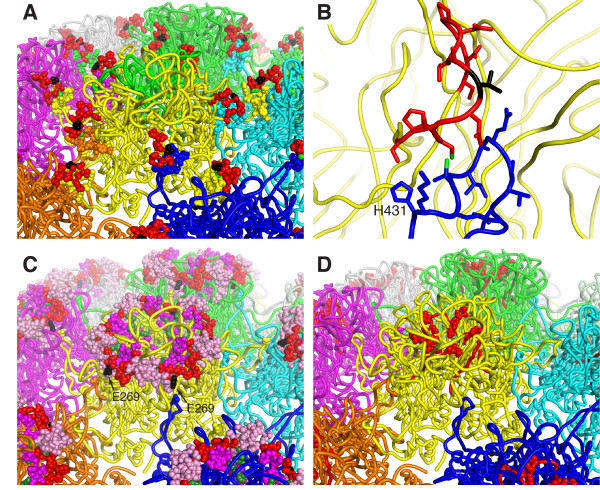
Fine mapping of antibody epitopes on the HPV16 capsid. (A) Same view as in Figure 7B, with the H16.H5 epitope (residues 173-185) shown in red. Side chains in the C-terminal arms of neighboring capsomeres that partially occluding the H16.H5 epitope are shown as colored spheres (not red). The conserved disulfide bond between Cys175 and Cys428 is highlighted with green spheres. The HPV16-specific Val178 is shown in black. (B) Close-up of the H16.H5 epitope from the subunit in the foreground of (A) with the same coloring scheme as in (A). (C) Same view as in (A), with the H16.V5, H16.E70, H263.A2 and H16.J4 epitopes highlighted: residues 261-265 (H16.J4 epitope only) are in dark green, residues 266-280 (in all four antibody epitopes) are in red, residues 281-297 (not part of the H16.J4 epitope) are in magenta. Residues 339-365 are in pink (not part of the H16.J4 epitope). Glu269 is shown in black. (D) Same view as in (A), with the H16.I23 epitope (residues 111-130) in red.